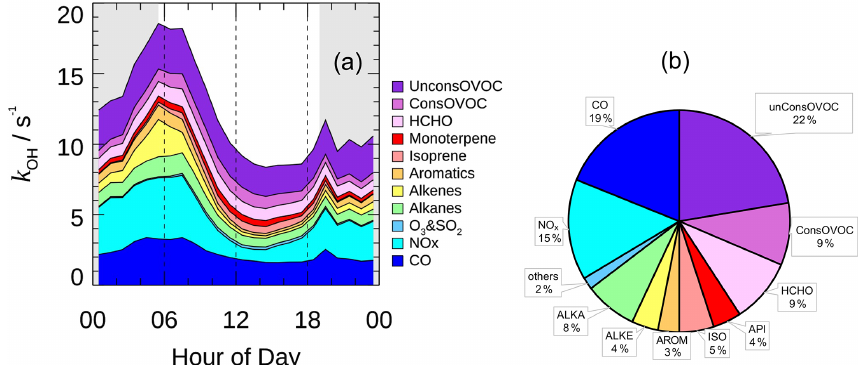
Figure 7. (a) The mean diurnal profiles of speciated OH reactivity. The grey areas denote nighttime. (b) Breakdown of modeled OH reactivity for daytime conditions (08:00–16:00).